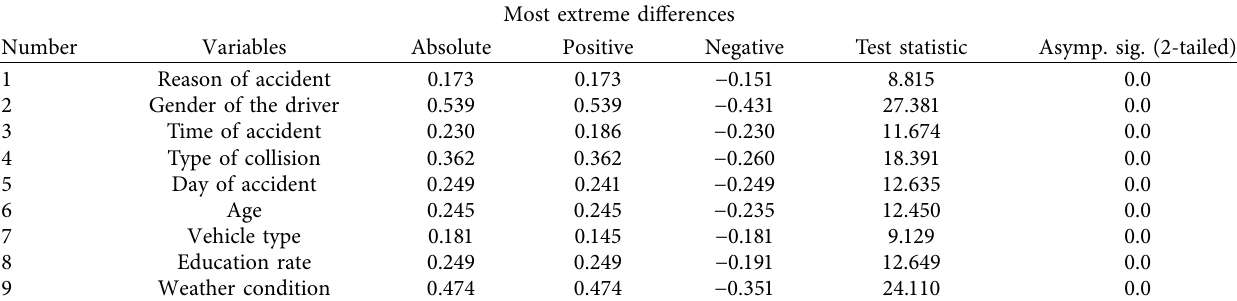
Figure 9: Statistics of vehicle accidents based on the condition of weather: (a) gender of the driver and (b) severity of the accident. Table 2: The Kolmogorov–Smirnov test results.